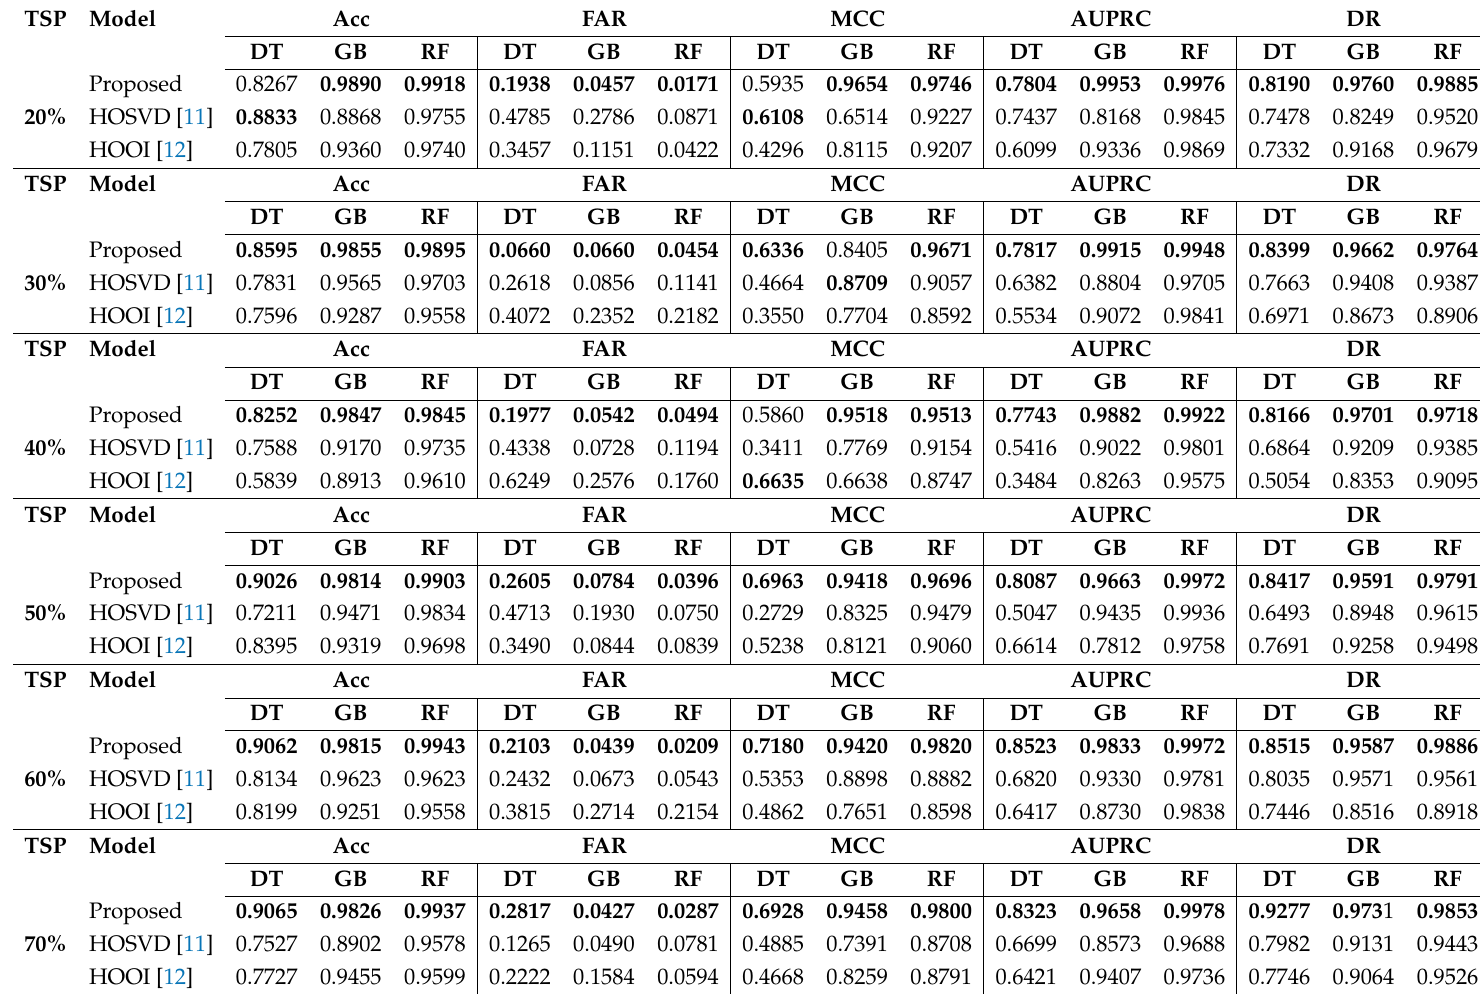
Table 5. Performance evaluation for different training size proportion, for a error level of